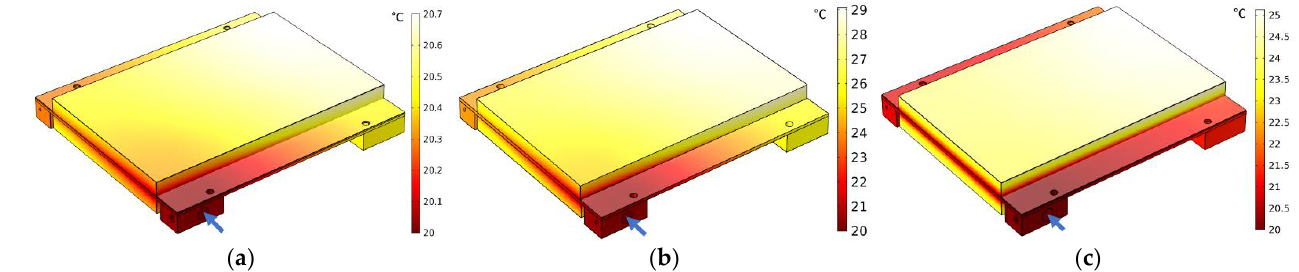
Figure 9. Simulated heat distribution in a unit of two pouch cells (rectangular block on top and bottom) and one cooling plate. Through the inlet (blue arrow) flows water into the cooling plate at an ambient temperature of 20 °C. ( a ) After discharging with 1 C and flow rate of 0.1 l/min and after discharging with 3 C at flow rate of ( b ) 0.1 l/min and ( c ) 0.5 l/min.